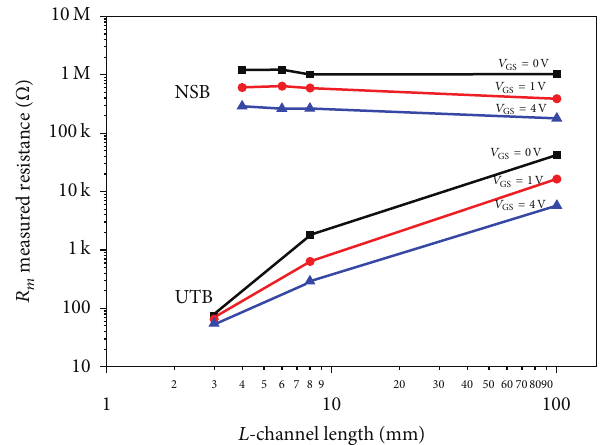
Figure 10: Comparison of the measured resistance 𝑅 𝑚 for NSB’s devices having a channel thickness of 1.86 nm, with UTBs devices (46nm channel thick), as function of channel length ( 𝐿 ) and several 𝑉 positive values. GS